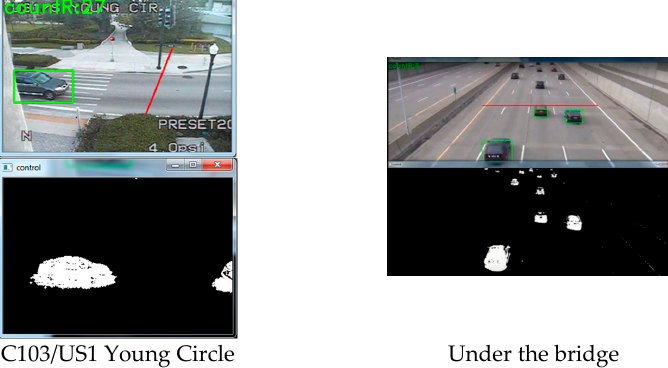
Figure 7. Background subtraction method results.